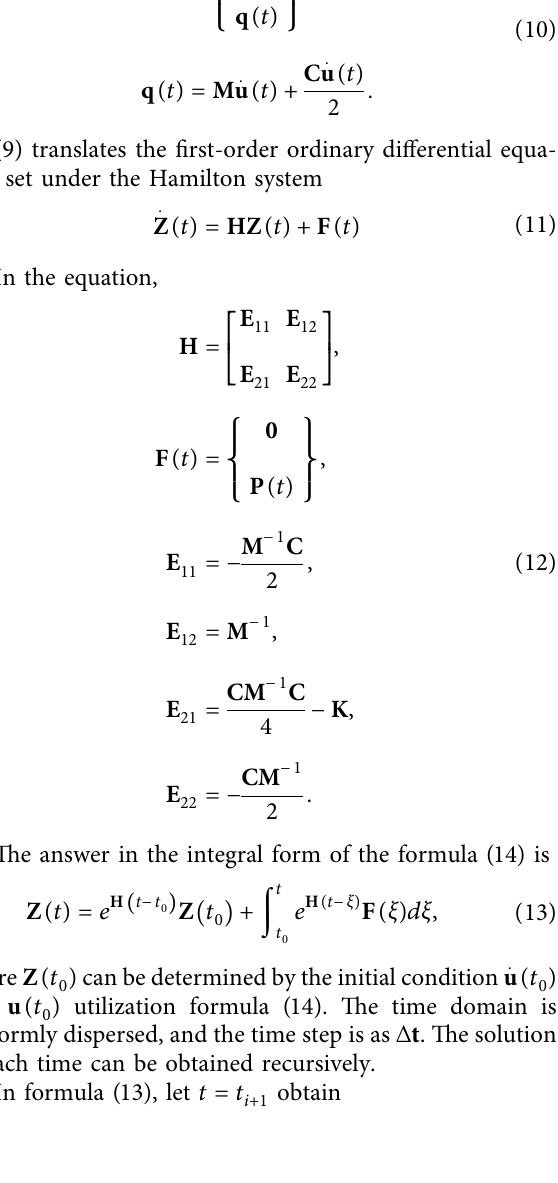
Table 1: Parameters table of ordinary basin rubber